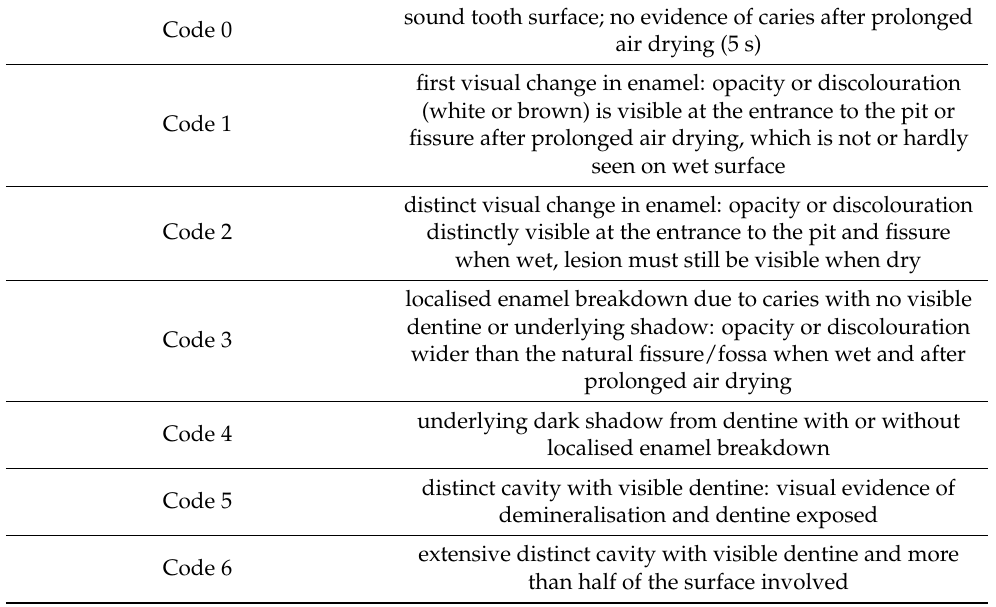
Table 1. International Caries Detection and Assessment System. sound tooth surface; no evidence of caries after prolonged Code 0 air drying (5 s) first visual change in enamel: opacity or discolouration (white or brown) is visible at the entrance to the pit or Code 1 fissure after prolonged air drying, which is not or hardly seen on wet surface distinct visual change in enamel: opacity or discolouration Code 2 distinctly visible at the entrance to the pit and fissure when wet, lesion must still be visible when dry localised enamel breakdown due to caries with no visible dentine or underlying shadow: opacity or discolouration Code 3 wider than the natural fissure/fossa when wet and after prolonged air drying underlying dark shadow from dentine with or without Code 4 localised enamel breakdown distinct cavity with visible dentine: visual evidence of Code 5 demineralisation and dentine exposed extensive distinct cavity with visible dentine and more Code 6 than half of the surface